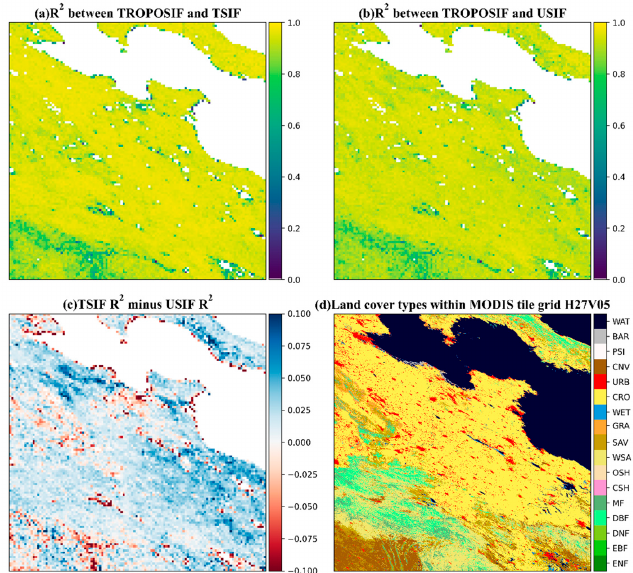
Figure 6. The temporal correlations of ( a ) TROPOSIF and TSIF and of ( b ) TROPOSIF and USIF; ( c ) the difference of TSIF R 2 minus USIF R 2 , R 2 refers to the temporal correlation; ( d ) the land cover types